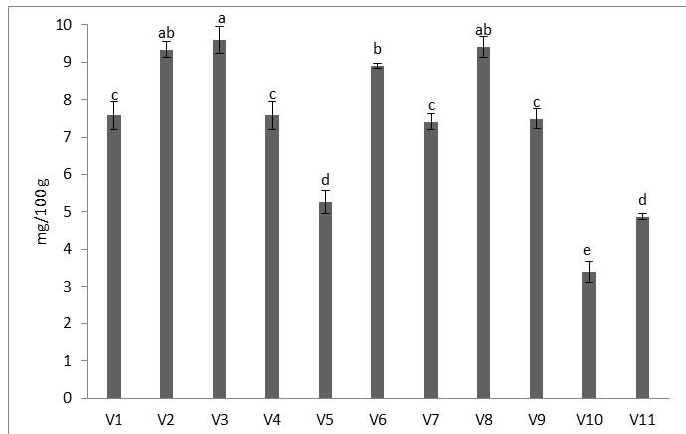
Figure 5. Lycopene content of tomato fruits cv. Brillante F1 treated with different fertilizers. Data are means ± SD. V1 = MgSO 4 , V2 = KNO 3 , V3 = K 2 SO 4 , V4 = Ca(NO 3 ) 2 , V5 = KH 2 PO 4 , V6 = KCl, V7 = MgSO 4 –KNO 3 –KH 2 PO 4 , V8 = K 2 SO 4 –Ca(NO 3 ) 2 –KCl, V9 = MgSO 4 –KNO 3 –K 2 SO 4 –Ca(NO 3 ) 2 –KH 2 PO 4 –KCl, V10 = one macroelement each day, V11 = H 2 O (Control). Different letters represents significant differences between the values according to Tukey post hoc test ( p < 0.05).